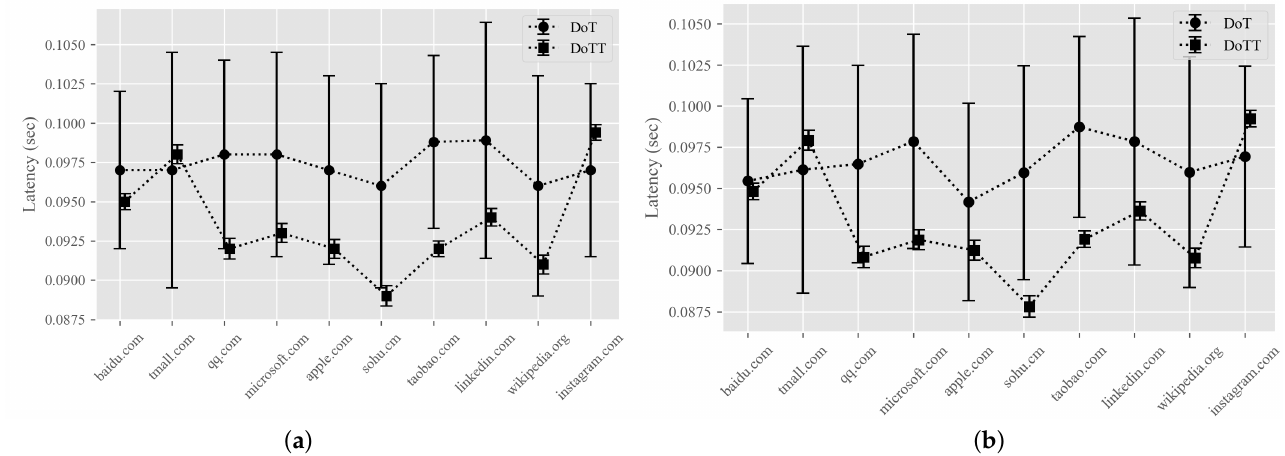
Figure 6. Performance evaluation of caching the resolved results between DoT and DoTT. ( a ) Caching 10 results, ( b ) caching 100